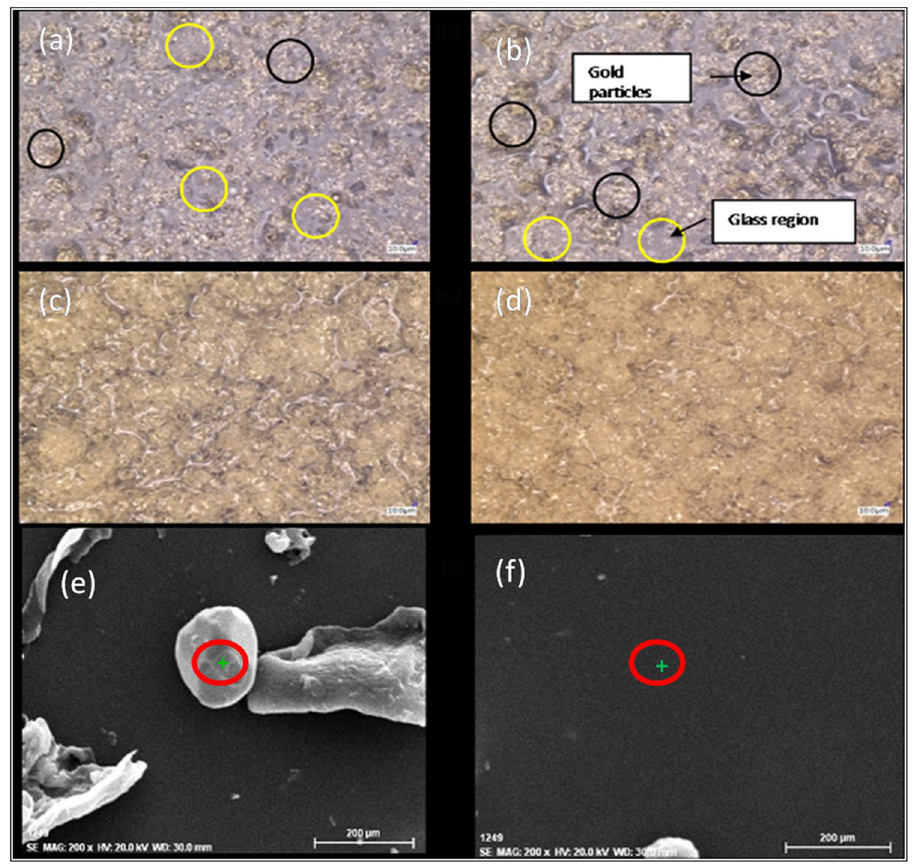
Figure 3. Optical micrograph of the phosphor layers on glass slides. ( a – d ) Are for the phosphor layer thickness corresponding to 14.12, 22.48, 30.53 and 36.52 μ m respectively. In ( a ) and ( b ) black outlined boxes show the gold color phosphor particles and the yellow outlined boxes show the grayish glass surface. ( e ) Is the SEM micrograph of a black outlined box for the confirmation of the phosphor particle and ( f ) is the SEM micrograph of a yellow outlined box for the confirmation of the glass area. The “ + ” symbols in ( e ) and ( f ) are the locations of EDS analysis where the results are shown in Table 1.